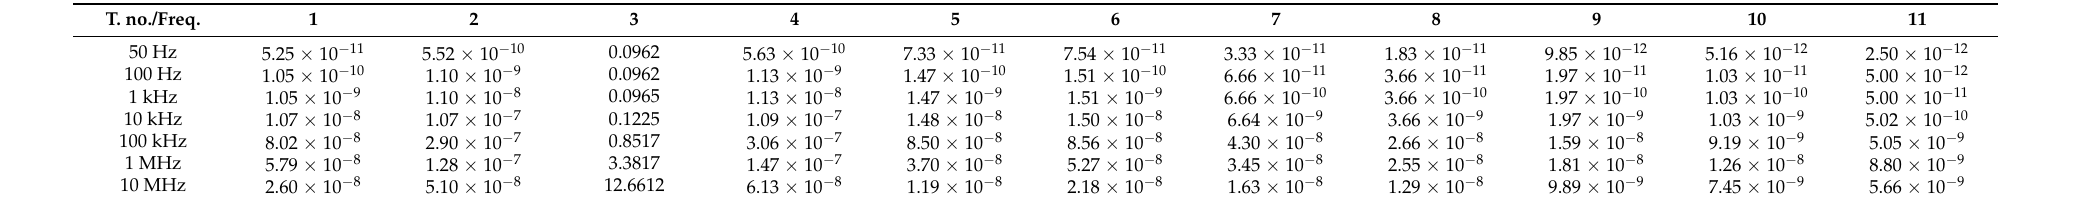
Table A12. Self and mutual resistances of turn 3 (in Ω ) resulting from FEM simulations. T. no./Freq.